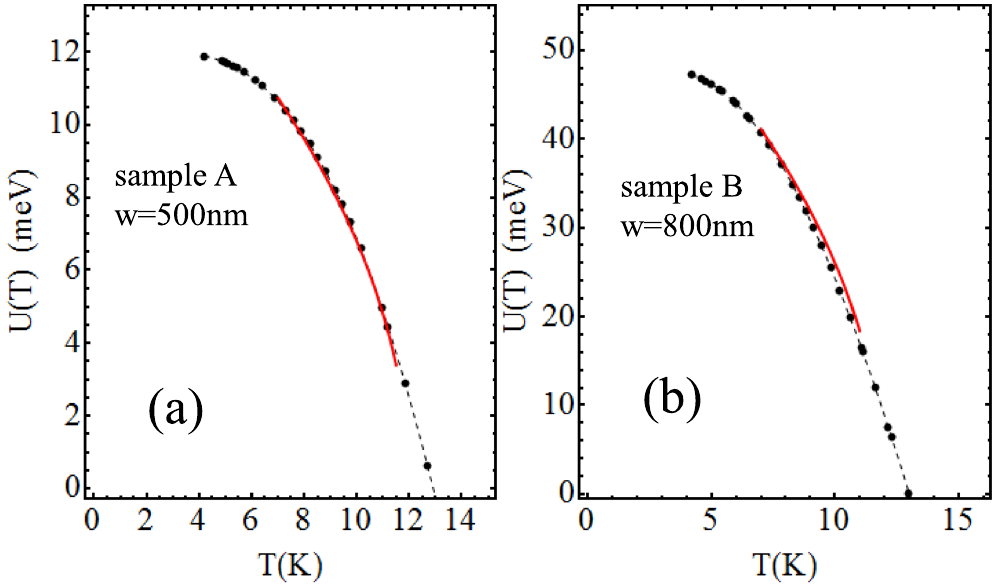
Figure 6. Experimental result of the temperature dependence of the pinning potential U(T) for sample A ( a ), and B ( b ). The red line in ( a , b ) shows the relation = . − U T U T T T ( ) 1 4 (0)